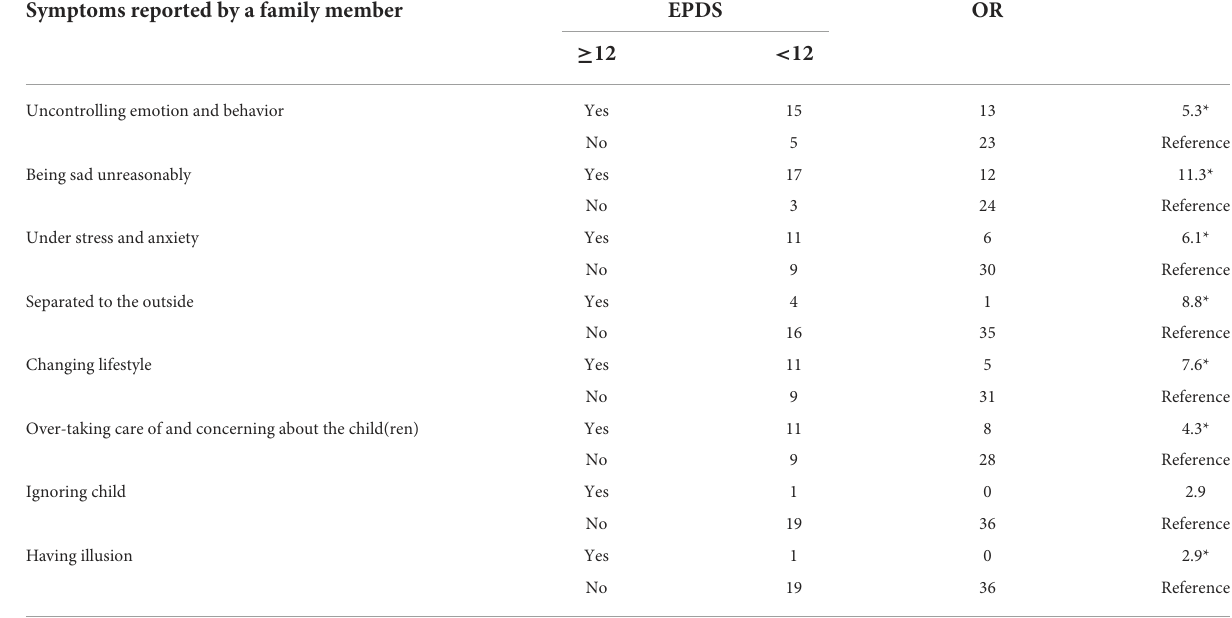
TABLE 2 Depression symptoms reported by family